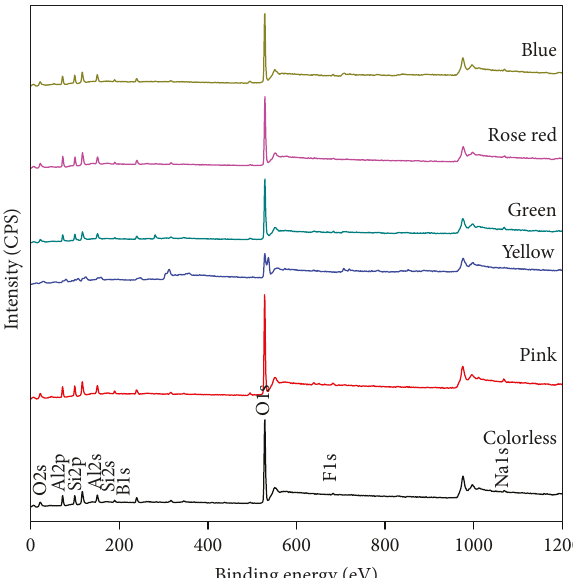
Figure 2: X-ray photoelectron spectra of tourmaline samples.